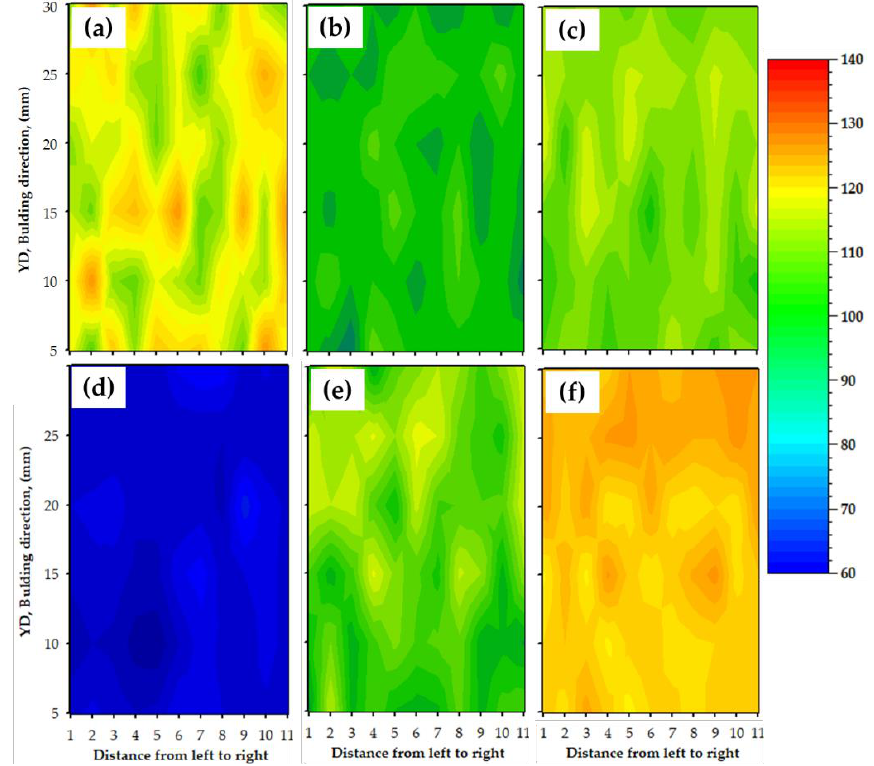
Figure 16. Hardness contours of the ( a ) initial material, ( b ) AMP, and ( c ) AMCP at temper condition of T6; ( d – f) hardness contours for the initial material, AMP, and AMCP at the temper condition of O.